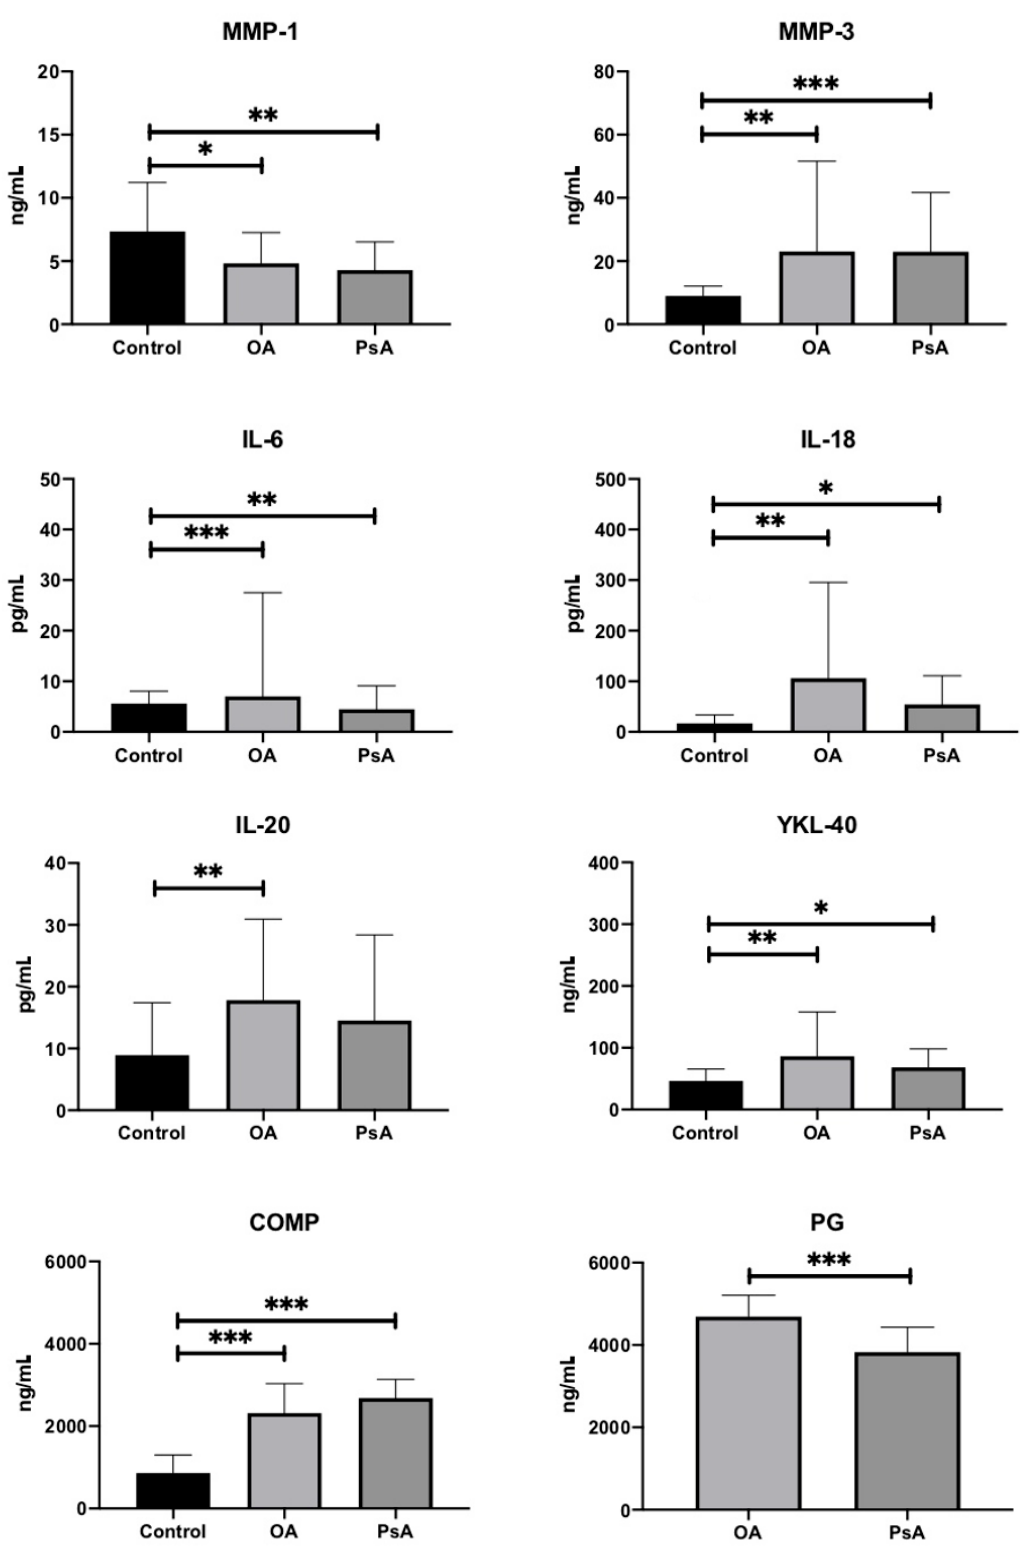
Figure 1. Serum concentration of MMP-1, MMP-3, IL-6, IL-18, IL-20, YKL-40, COMP, and PG-AG in studied groups. Data presented as means (boxes) with standard deviations (whiskers). A comparison between groups was made using Kruskal-Wallis ANOVA (or Mann-Whitney U test) with post-hoc testing indicated above each box-plot. The level of statistical significance indicated with asterisk: * p < 0.05, ** p < 0.01, *** p <